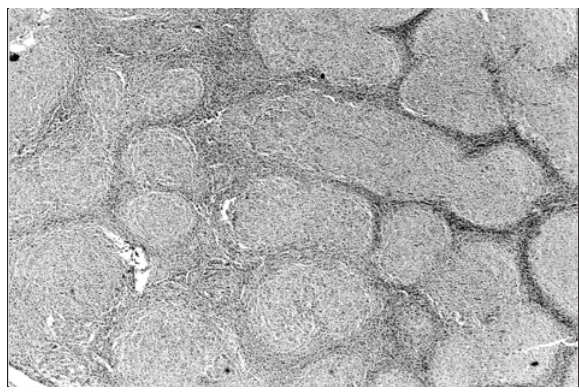
Figura 5 – Linfoma folicular de pequenas células (grau I): folículos linfóides justapostos com zona do manto escassa ou ausente